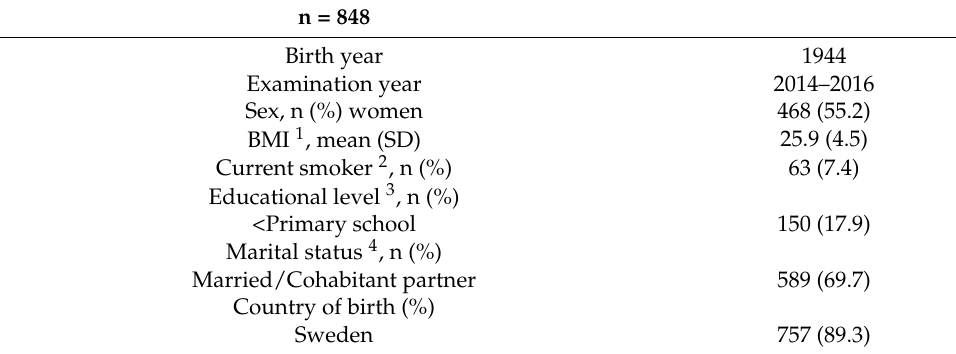
Table 1. Characteristics of